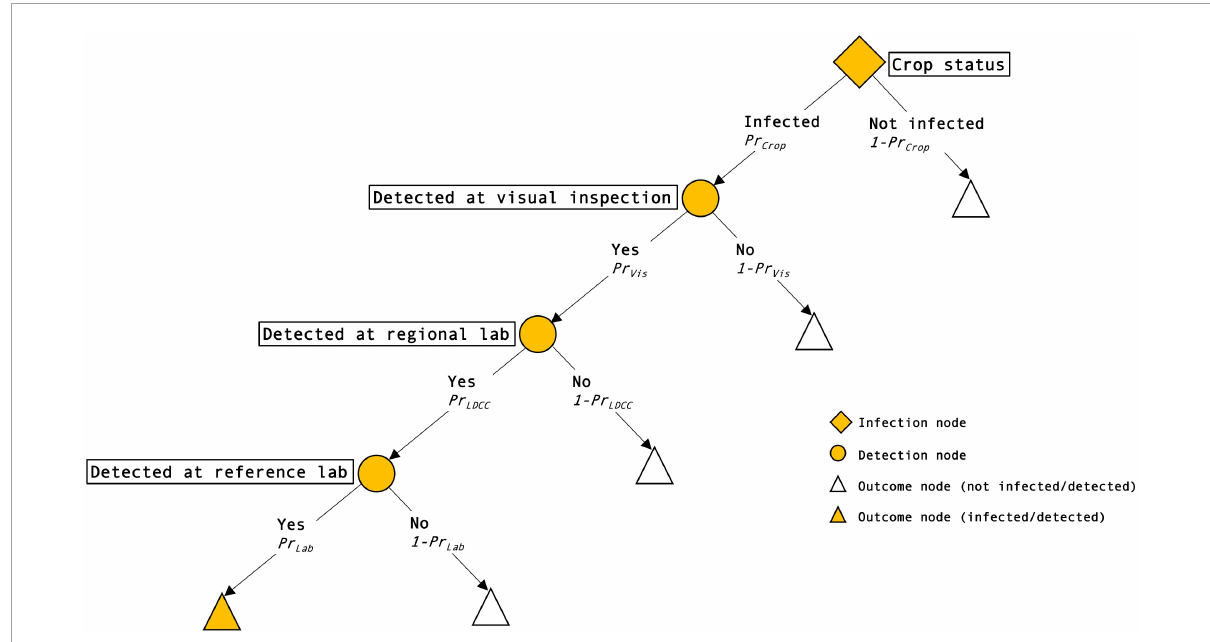
FIGURE1 Representation of the surveillance system as a scenario tree. In sequence of events, the surveillance system consists of infection node or crop status (filled diamond), detection nodes where visual inspection and laboratory testing is undertaken (filled circles), and outcome nodes (triangles). Outcome nodes represent infected/detected crop proportions (filled triangles) and not infected/detected crop proportions (empty triangles).